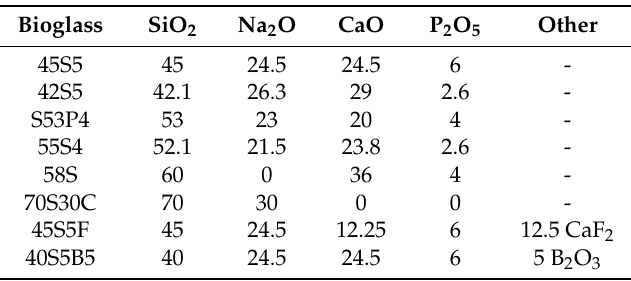
Table 1. Composition of bioactive glass. Data are reported as a percentage and refer to the concentration by weight of the